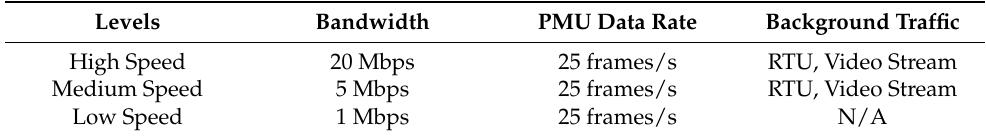
Table 2. Parameters of the communication